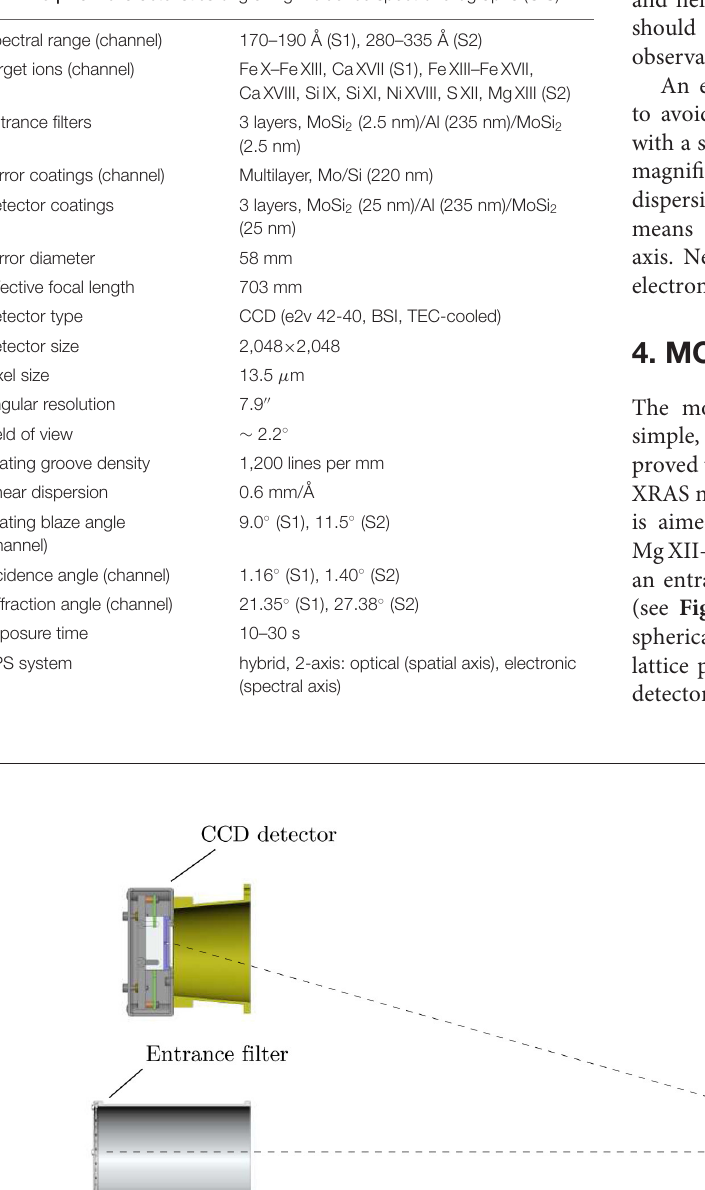
TABLE 3 | Main characteristics of grazing-incidence spectroheliographs (GIS).